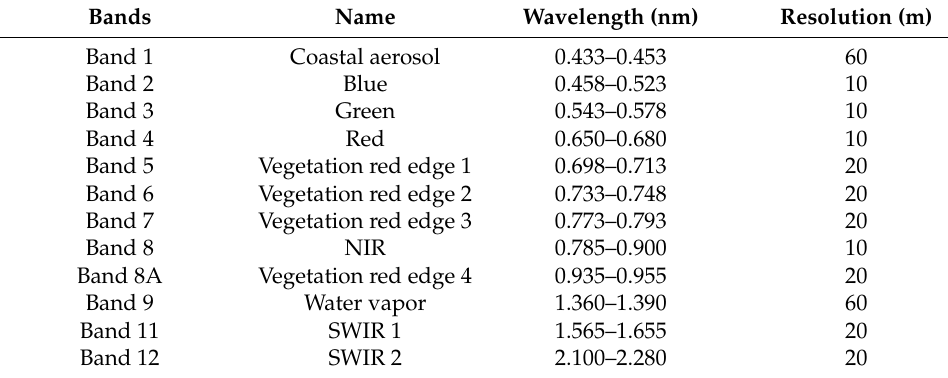
Table 2. Sentinel-2 band parameters.